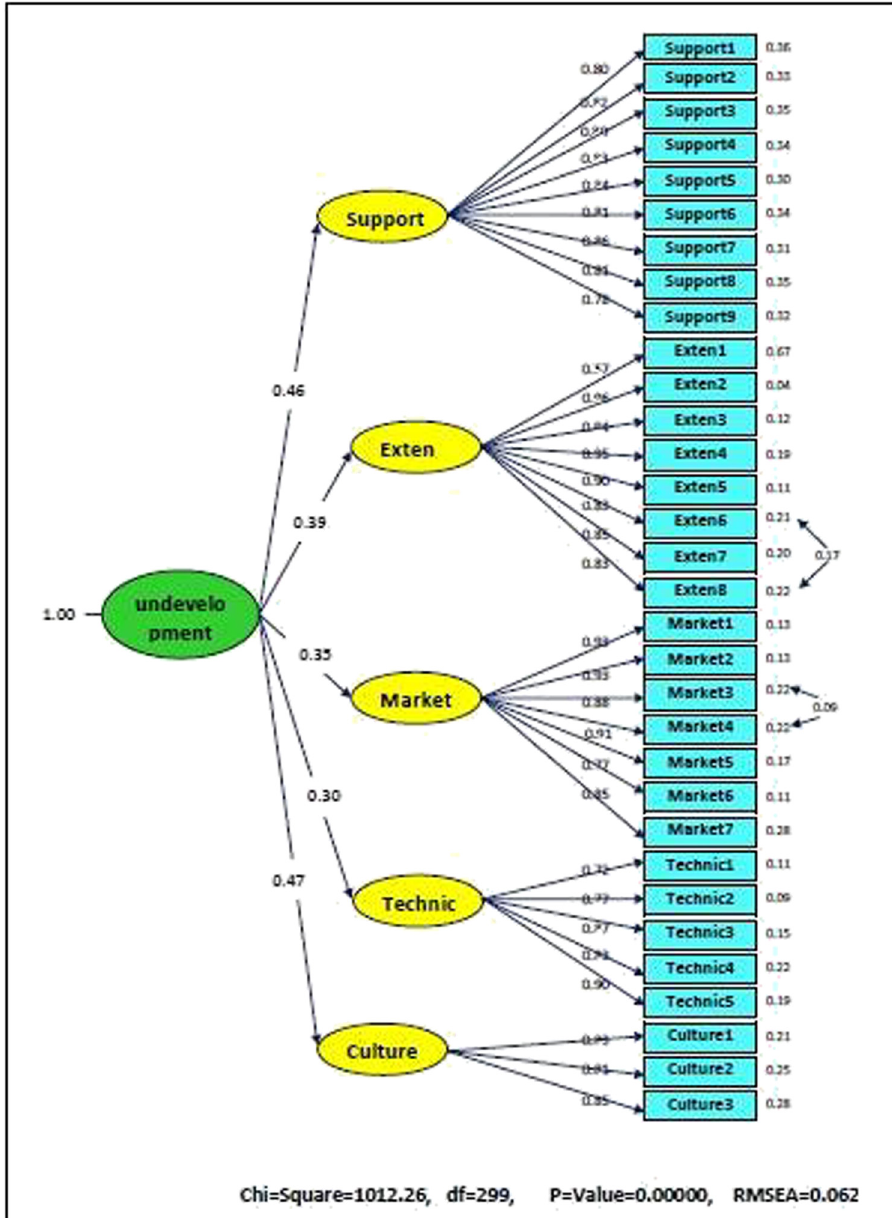
Figure 3: Con fi rmatory factor analysis ( CFA ) model with standardized factor loads display ( LISREL software output image )